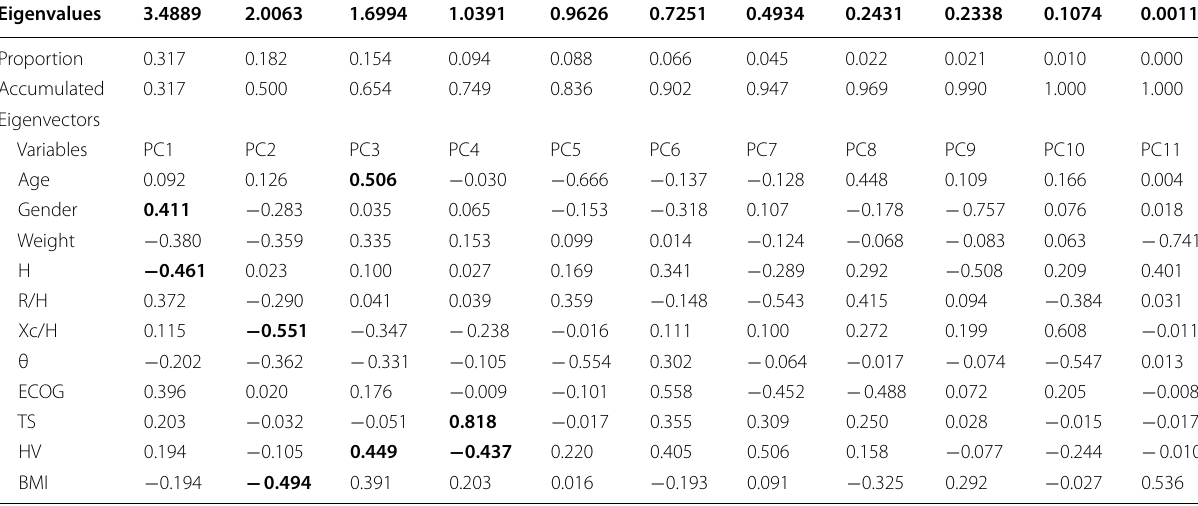
H, R/H, Xc/H, θ, ECOG, TS, HV, and BMI were the height of patient, body electrical resistance divided by H, body electrical capacitive reactance divided by H, body phase angle, Eastern Cooperative Oncology Group, tumor stage, histological variety of the tumor, and body mass index, respectively. PCi (i principal component